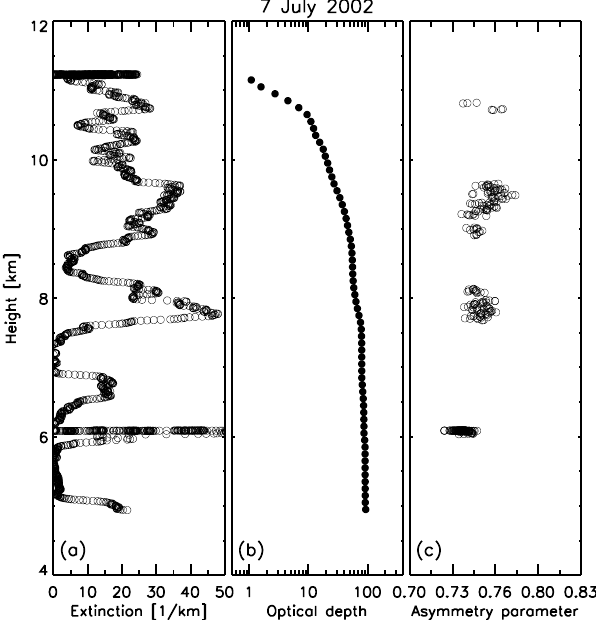
Fig. 7. CIN retrievals of extinction (a) ; optical depth (b) ; and asym- metry parameter (c) for data collected during the spiral of the Cita- tion aircraft on 7 July